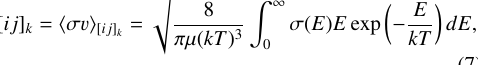
about 3 times smaller than the one predicted by the